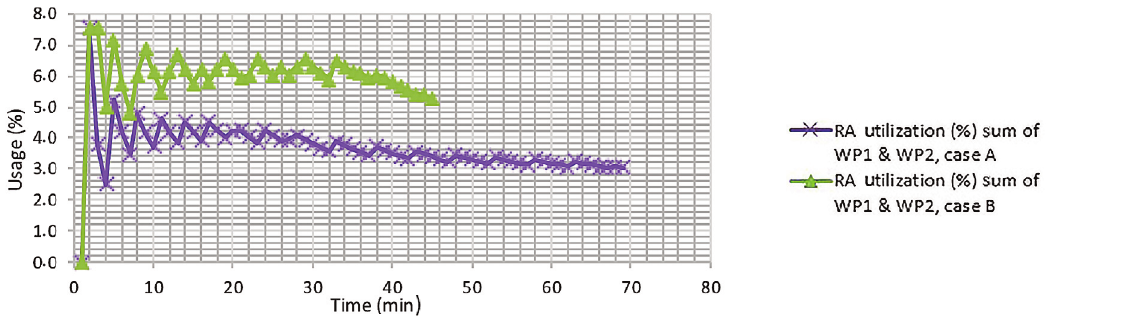
Fig. 4. Robot arm